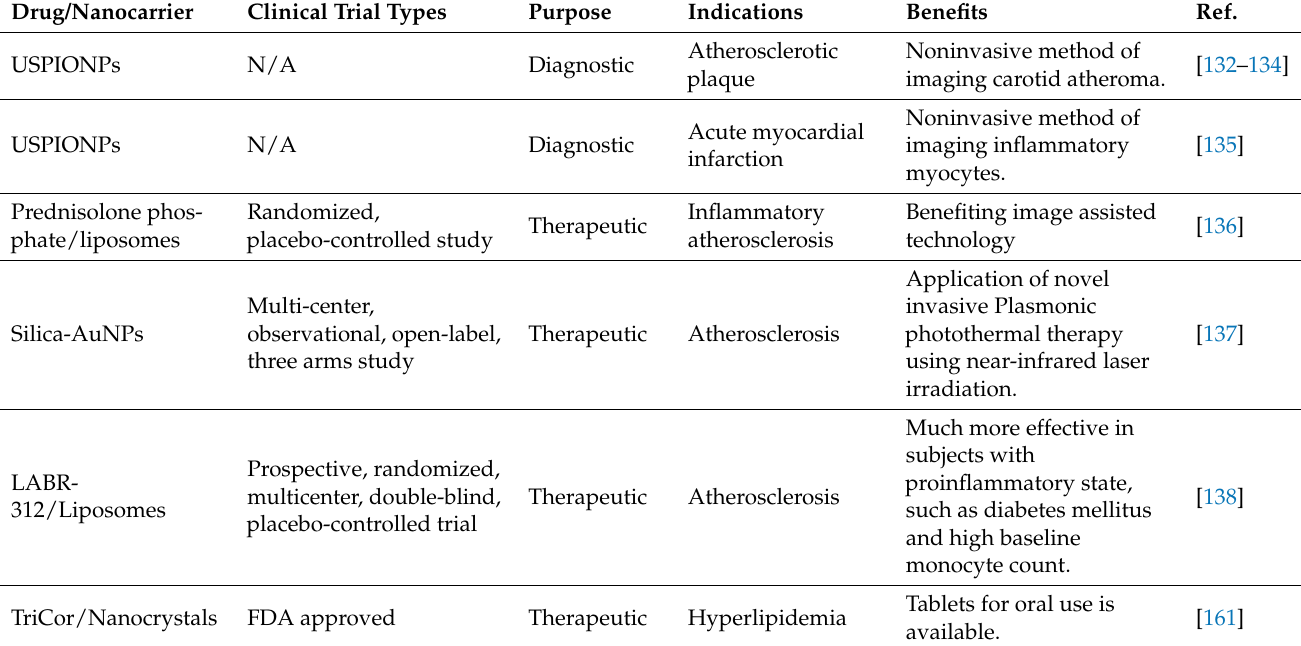
Table 3. List of nanomedicine approved by FDA or presently in clinical trial for diagnosis or therapy of